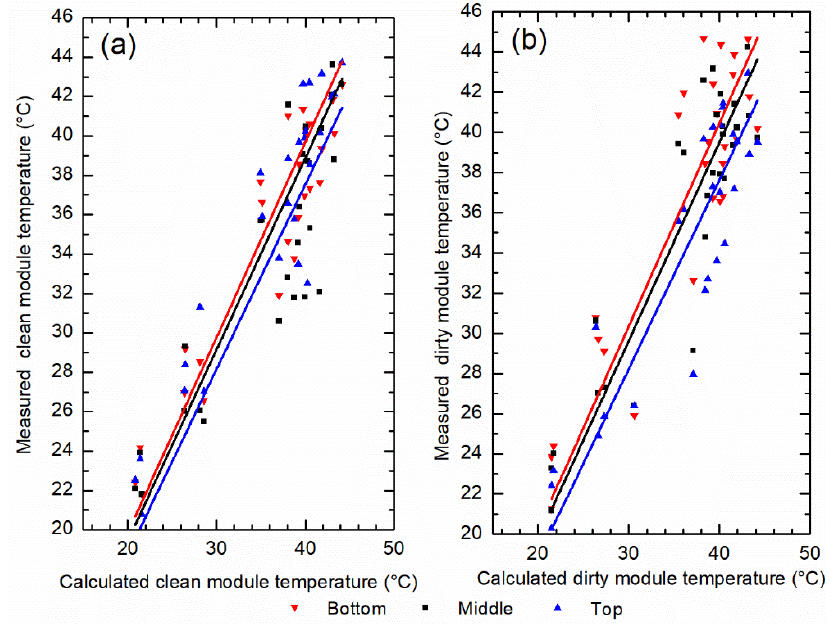
Figure 6. Plot of temperatures measured in low, middle, and upper zones, showing the calculated temperature for the same conditions in ( a ) the clean photovoltaic (PV) module and ( b ) the dirty PV module.